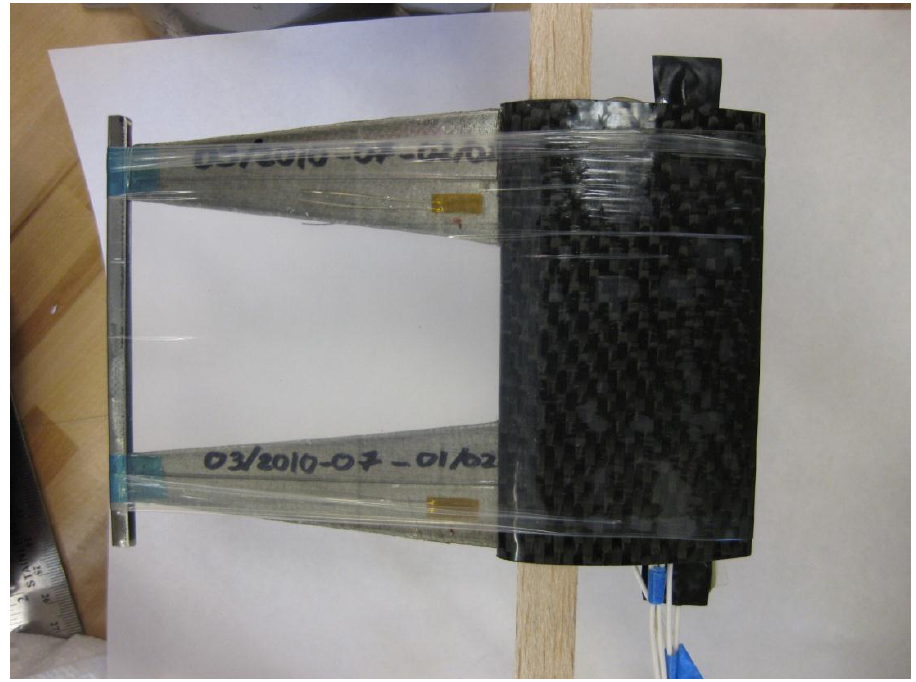
Figure 5. Manufactured airfoil with elastic skin.